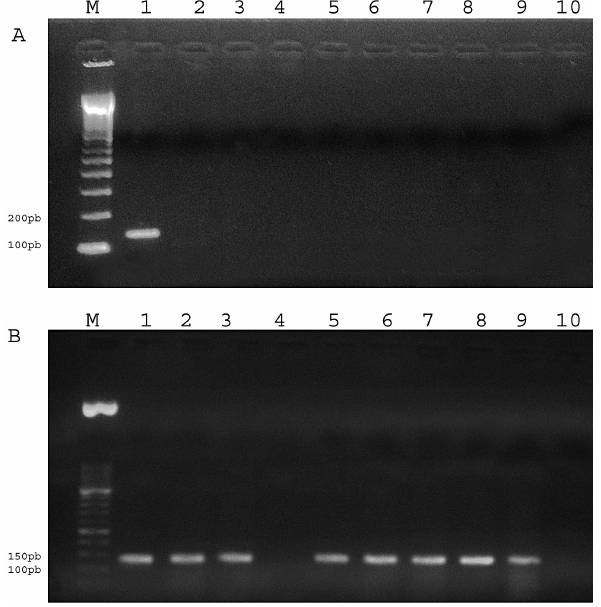
Fig. 1. – Sample amplifications of stool specimens. A - E. histolytica amplification. M: DNA molecular weight marker XIII, 100 bp ladder (Roche); lane 1, positive control; lanes 2-9, nega- tive samples; lane 10, negative control. B - E. dispar amplification. M: DNA molecular weight marker XIII, 50 bp ladder (Roche). Lane 1, positive control; lanes 2-3 and 5-9, posi- tive samples; lane 4, negative sample; lane 10, negative control.